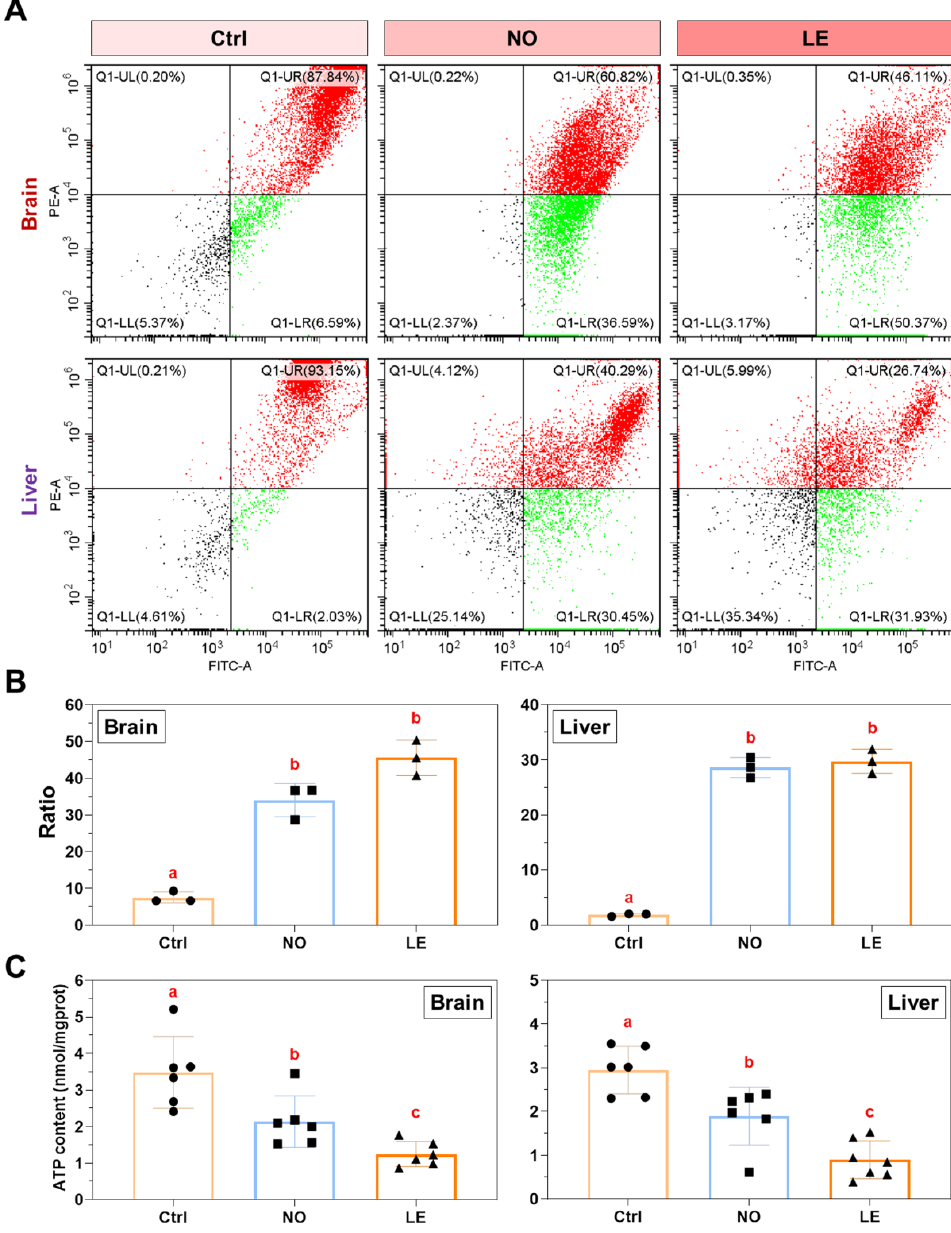
Figure 5. Mitochondrial membrane potential and tissue ATP content. ( A ) Measurement of mito- chondria membrane potential (MMP) by JC-1 staining and flow cytometry. ( B ) Ratio of green/red fluorescence, which reflects change in mitochondria membrane potential. ( C ) Tissue ATP concen- tration. The error bars represent SD ( n = 3). The dots, squares and triangles represent data of the corresponding experimental groups shown in the horizontal axis. Different letters above the error bars indicate significant difference between the means ( p ≤